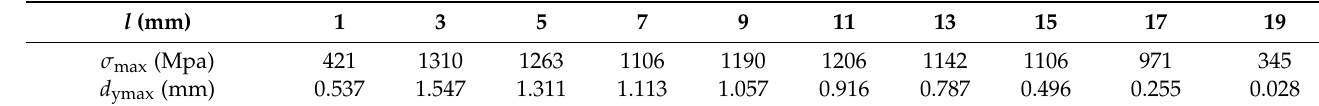
16. Results show the rotational stiffness model is highly accurate. Table 2. Maximum stress σ max and deformation d ymax of the leaf spring.